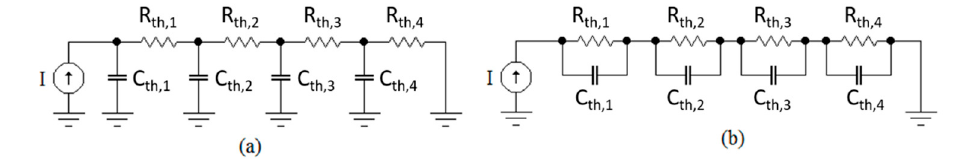
Figure 2. ( a ) Cauer thermal network; ( b ) Foster thermal network.